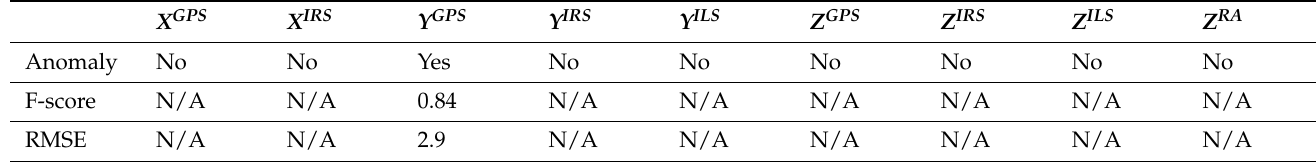
Table 7. Result for each signal after using